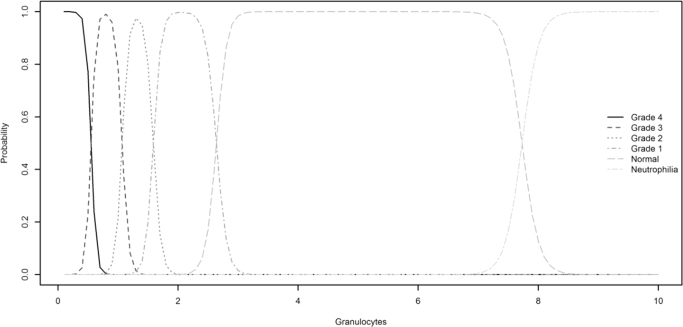
Neutropenia grading probabilities produced by the multinomial logistic regression classifier on granulocyte counts from 0.1 to 10×109cells/L.